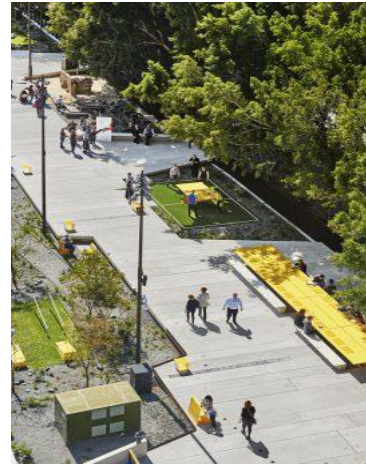
Fig. 3. The use of low-energy luminescent in space. *